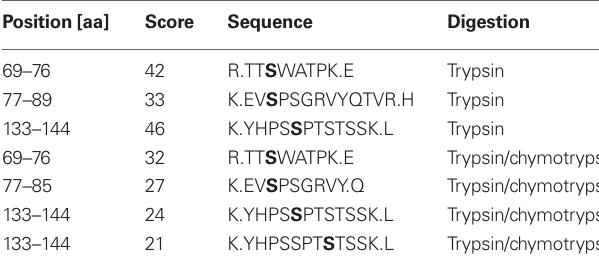
Table 1 | Phosphorylated MP17